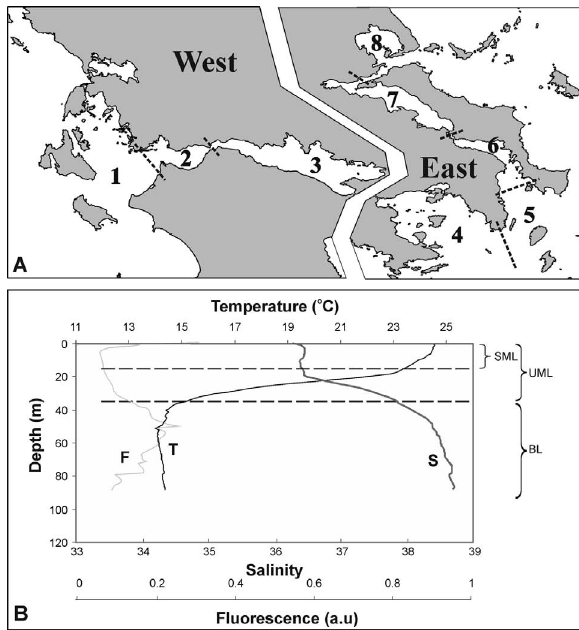
Fig . 2. – (A) Division of the surveyed area into west and east re- gions. The sub-regions considered in the study are also indicated (1, Ionian Sea; 2, Patraikos Gulf; 3, Korinthiakos Gulf; 4, Saronikos Gulf; 5, Aegean Sea; 6, S. Evoikos Gulf; 7, N. Evoikos Gulf; 8, Pagasitikos Gulf). (B) Example of vertical profiles of temperature, salinity and fluorescence at a station. The different water column layers are indicated: upper mixed layer (UML), surface mixed layer (SML) and bottom layer